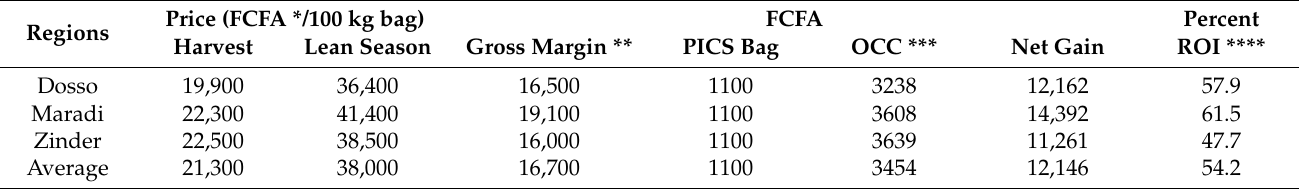
Table 6. Estimates of return on investment (ROI) when farmers stored cowpea using a 100kg PICS bag for 6 months in Dosso, Maradi, and Zinder regions of